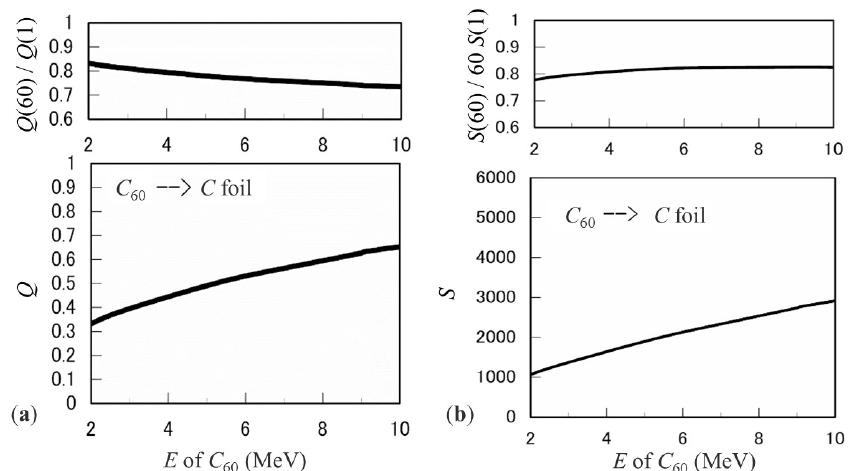
Figure 23. ( a ) Average charge per atom Q and its ratio to single C ion, Q ( 60 ) / Q ( 1 ) , and ( b ) stopping cross section S of carbon in units of 10 − 15 eV cm 2 /atom for a C 60 ion and its ratio S ( 60 ) / ( 60 S ( 1 )) to a C ion with equivalent speed as a function of the incident energy.